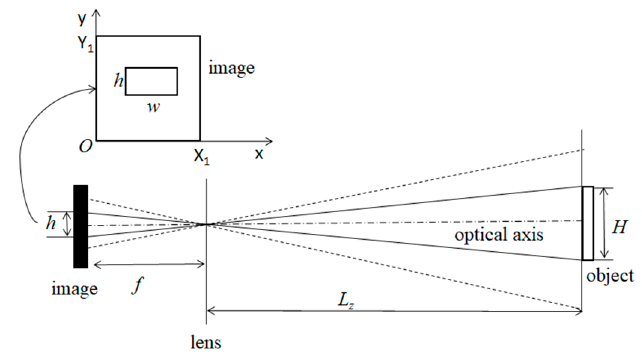
Figure 9. The 2D imaging model of a camera.